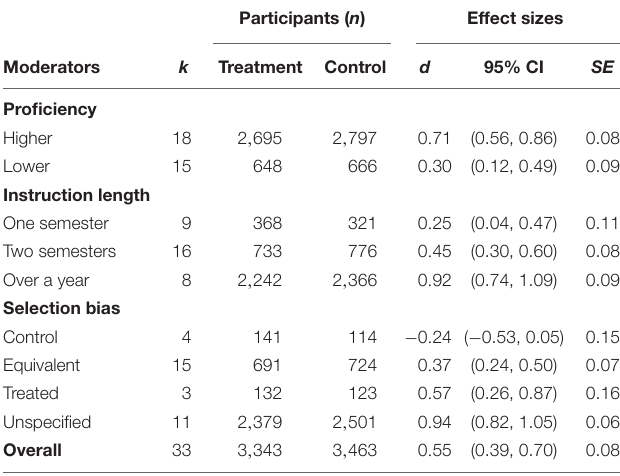
TABLE 3 | Results of the meta-analysis for the treatment effects of extensive